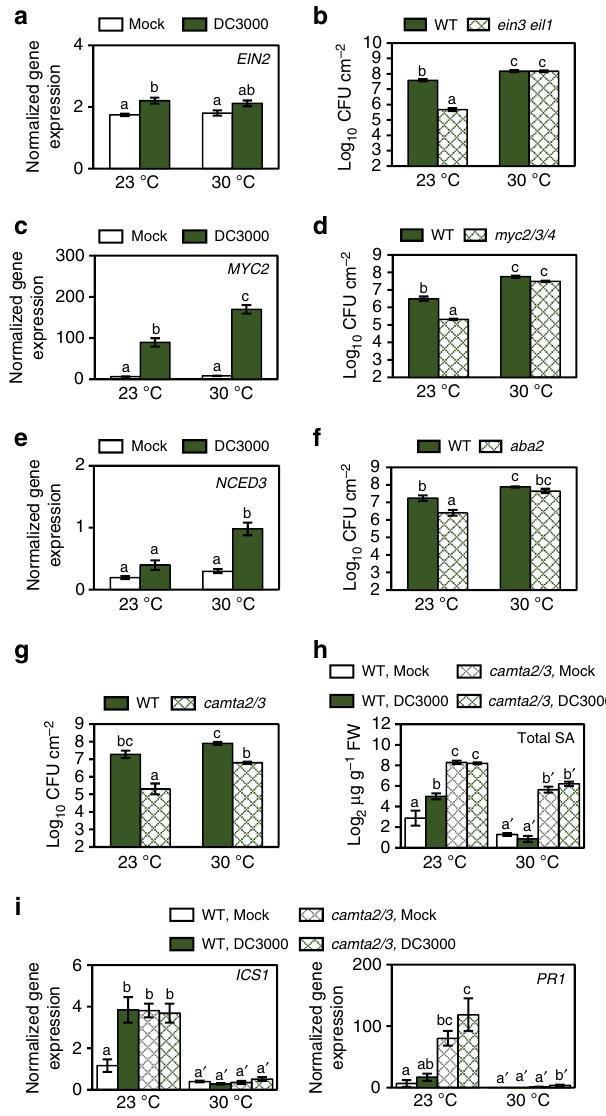
Fig. 6 Major SA antagonistic pathways are not responsible for enhanced susceptibility to Pst DC3000 at elevated temperature. a ET, c JA and e ABA marker gene expression in plants ( n = 3) 24 h after vacuum-in fi ltration with mock or Pst DC3000. Bacterial growth in WT and b ein3 eil1 , d myc2/3/4 , f aba2 and g camta2/3 mutant plants ( n = 4) 3 days after vacuum- in fi ltration with Pst DC3000. h SA metabolite quanti fi cation and i SA marker gene expression in WT and camta2/3 mutant plants ( n = 4) 3 days after vacuum-in fi ltration with mock or Pst DC3000. Gene expression and LCMS data were processed and analysed as described in Fig. 2. Data are presented as the mean ± s.e.m. with n = biological replicates and are representative of three independent experiments. Letters indicate statistical signi fi cance based on a two-factor ANOVA with Tukey ’ s HSD post hoc analysis ( p < 0.05); samples sharing letters are not signi fi cantly different. Data in h and i were analysed in two groups based on